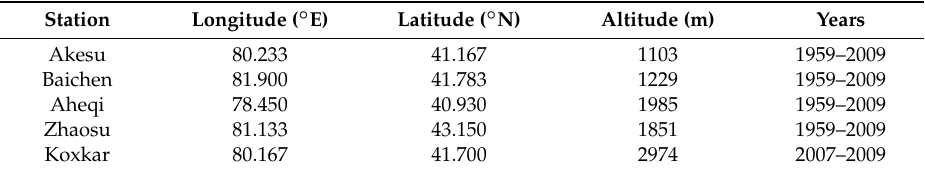
Table 2. Details of the Camp-AWS and the four national meteorology stations (NMS) around the Koxkar River Basin. AWS: automatic weather station.